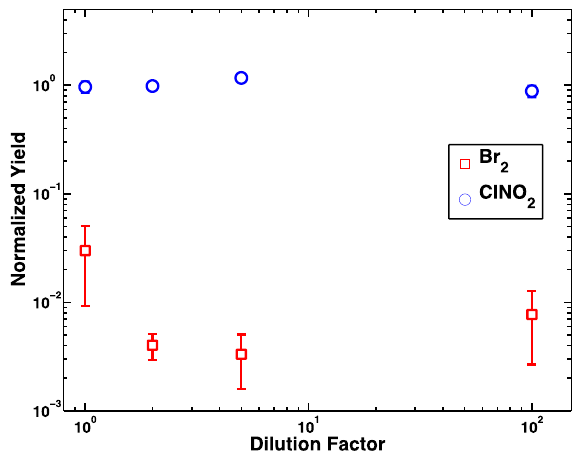
Fig. 4. The normalized yields of products of the reaction of N2O5 on synthetic sea ice surfaces are plotted as a function of the dilution factor applied to a standard seawater solution (Cl:Br = 650:1) prior ) measured at to freezing. The absolute yields ( 1 S halogen / 1 S N 2 O 5 dilution factors > 1 are normalized to the average total halogen yield ( ∼ 1) from multiple determinations on synthetic sea ice (dilution factor =1). A dilution factor of 1 corresponds to a salinity of 35 parts per thousand in the solution prior to freezing, while a dilution factor of 10 corresponds to 3.5 parts per thousand and so on. The results are consistent with the fact that as the ice freezes it rejects the salts into a highly saline interface layer – the ionic composition of which is set by humidity and temperature. The error bars rep- resent the 1 σ deviation of multiple determinations in each dilution factor